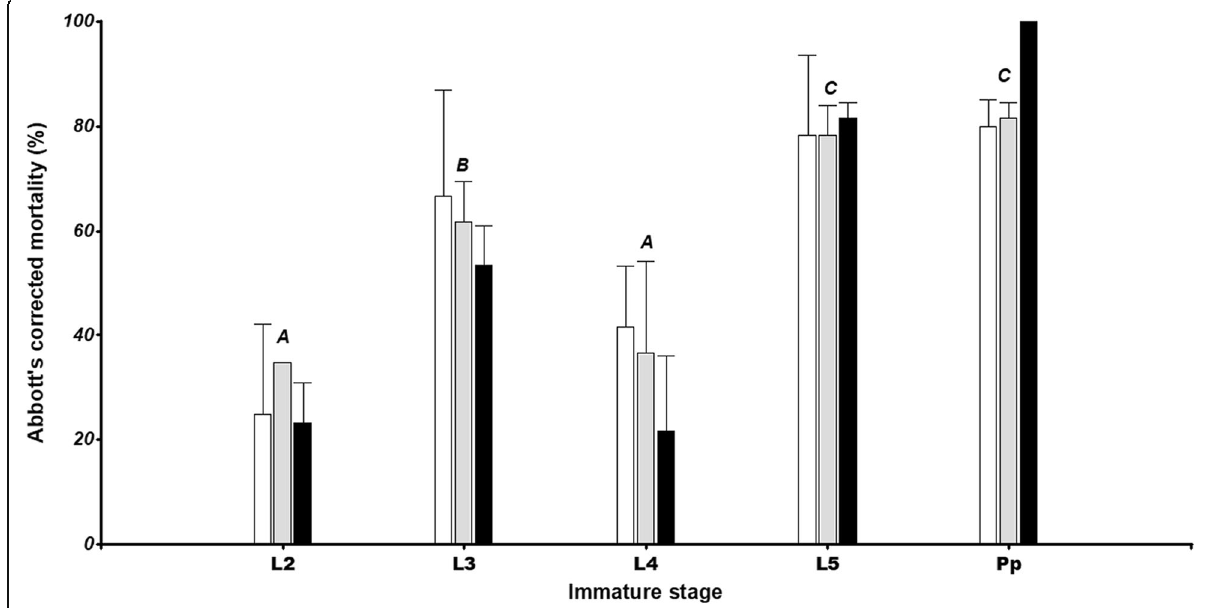
Fig. 1 Corrected mortality of Lobesia botrana larvae (L 2 – L 5 ) and pupae (P p ) caused by the entomopathogenic fungus Metarhizium anisopliae after 7 days of exposure. Error bars represent standard deviation for three replicates. Different letters indicate significant differences only among immature stages. Columns represent corrected mortality caused by CEP413 (white), CEP589 (gray), and CEP591